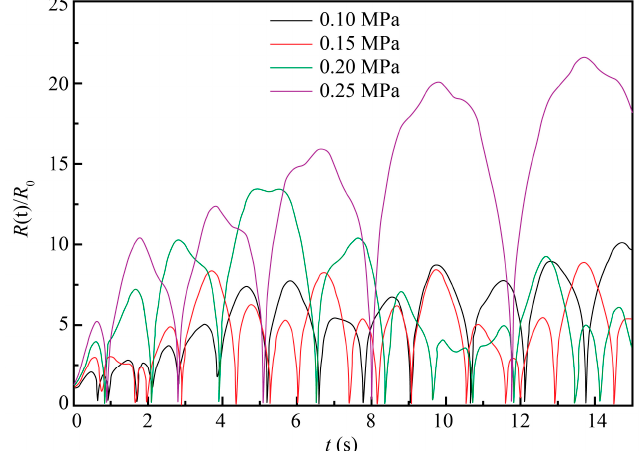
Figure 4. Evolution of cavitation bubble oscillation amplitude at four different ultrasound pressures and constant ultrasound frequency ( f ) = 20 kHz.